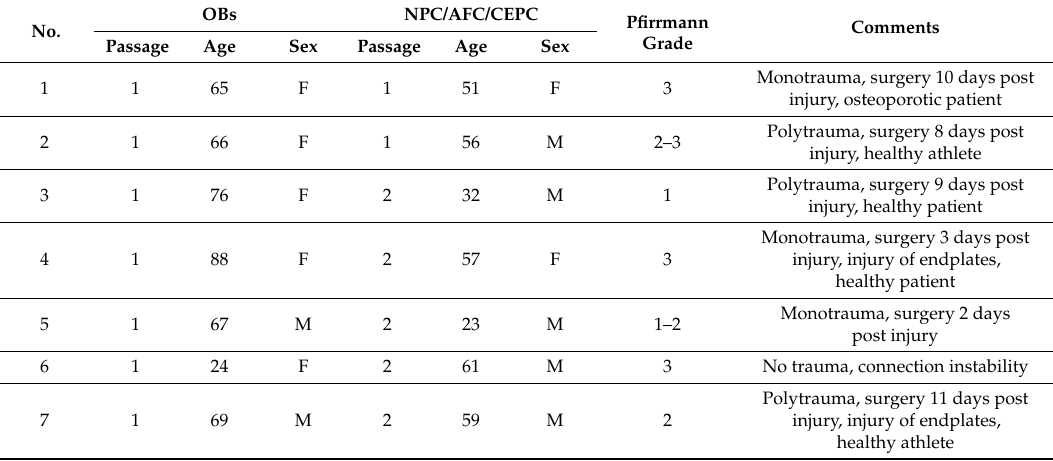
Table 1. Donor list of osteoblasts (OB) and intervertebral disc cells (nucleus pulposus (NPC),